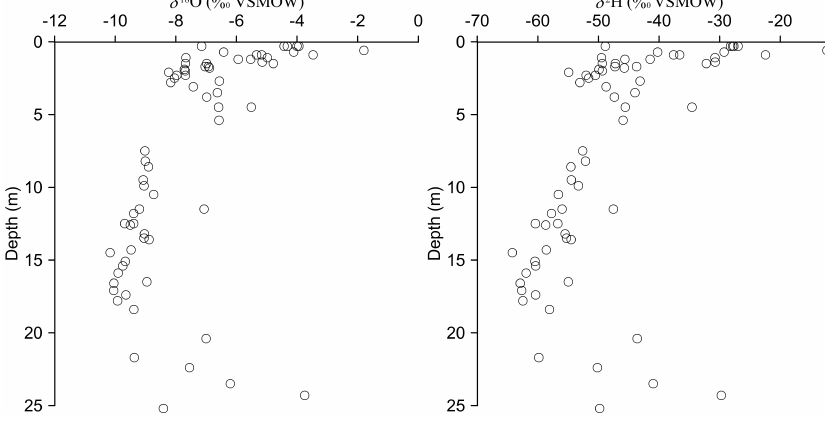
Figure 9. The variation of δ 18 O and δ 2 H in water and ice extracted from sediment cores with depth at cluster